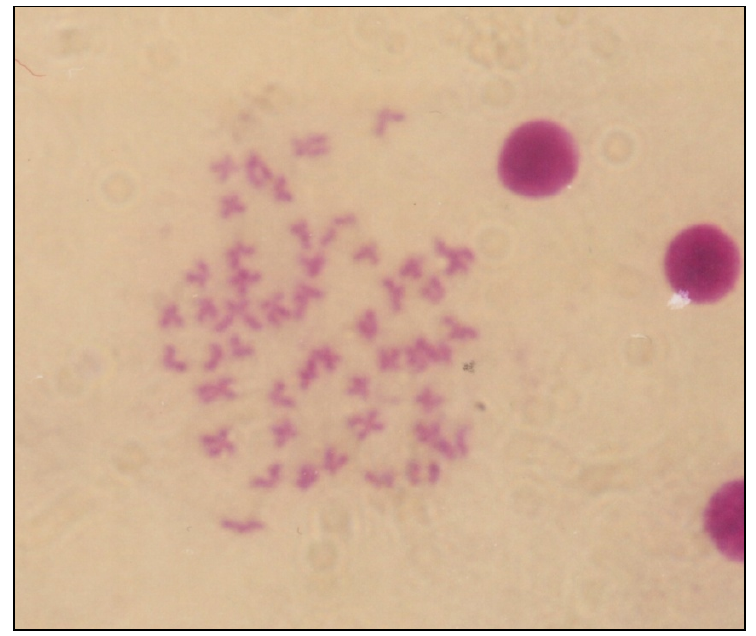
F IGURE 1. Metaphase chromosomes of pike ( Esox lucius ) in this study